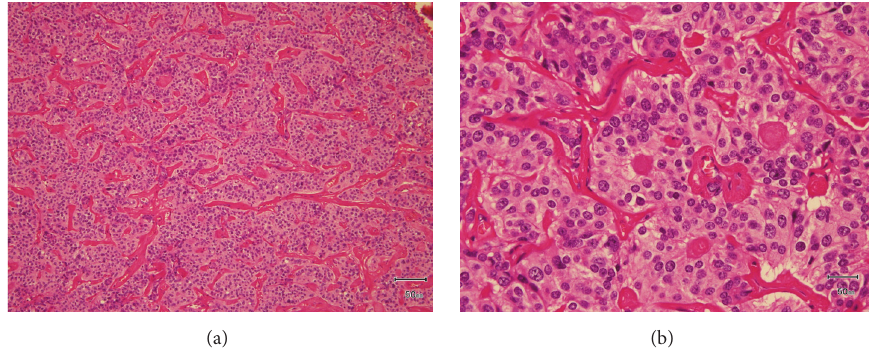
Figure 4: HE staining with low power (a) and high power (b). The round cells were arranged as cords, solids, trabeculae, and nests with a highly vascularized, hyalinized stroma. There was no necrosis, and the mitotic count was < 1/10 HPF.